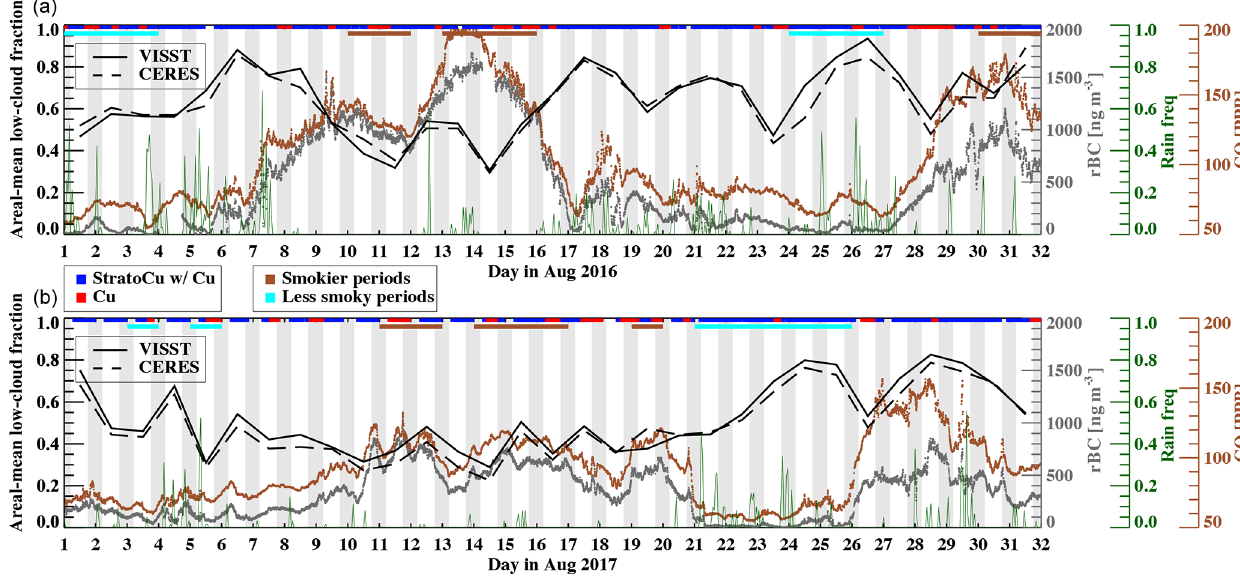
Figure 4. (a) August 2016 time series of refractory black carbon mass and carbon monoxide concentrations (rBC and CO, gray and brown filled circles respectively) and disdrometer-derived hourly rain frequencies (dark green curves) at the AMF1 site, and daily low-cloud frac- tions averaged over 6–10 ◦ S, 11–15 ◦ W. (b) Similar time series for August 2017. The daily-mean Meteosat10 VISST and CERES Terra and Aqua low-cloud fractions are indicated in solid and dashed black lines, respectively. The visual surface-based cloud classification is indicated above each panel, color-coded in red, for “cumulus of little vertical extent”, and blue, for “stratocumulus and cumulus with bases at different levels”. The “more” and “less” smoky days contributing to each group are also indicated above each panel, color-coded in brown and cyan,